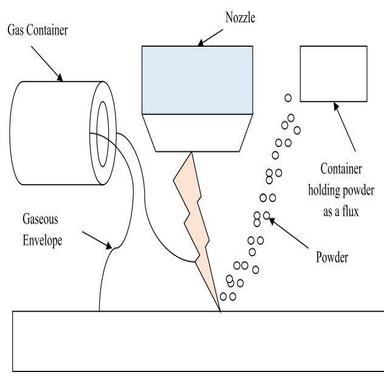
Working of direct energy deposition.